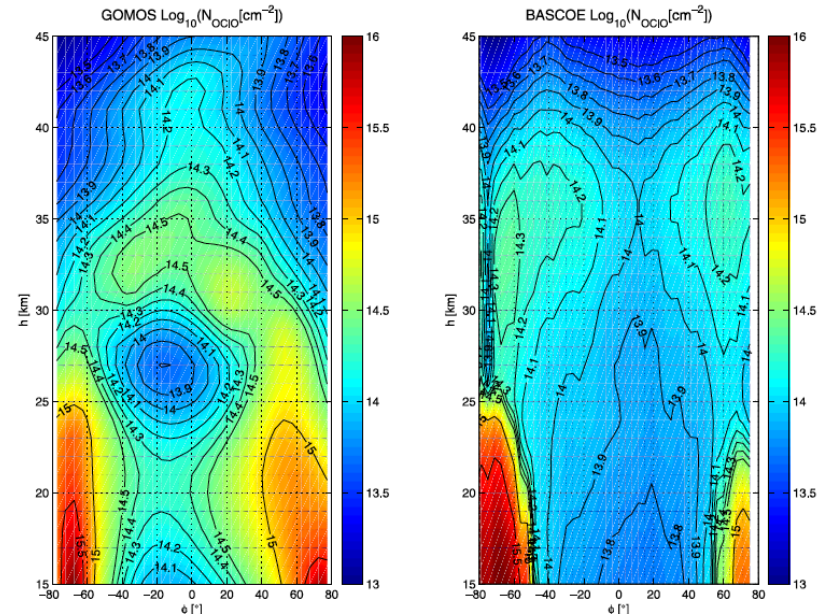
Fig. 37. Isocontours (latitude-altitude) of the OClO slant column densities measured by GOMOS and modeled by the BASCOE model at the same geolocation and time for the measurement periods (14 January–9 February 2003) and (20 July–30 December 2003). Both polar regions are probed during polar night (from Fussen et al., 2006).